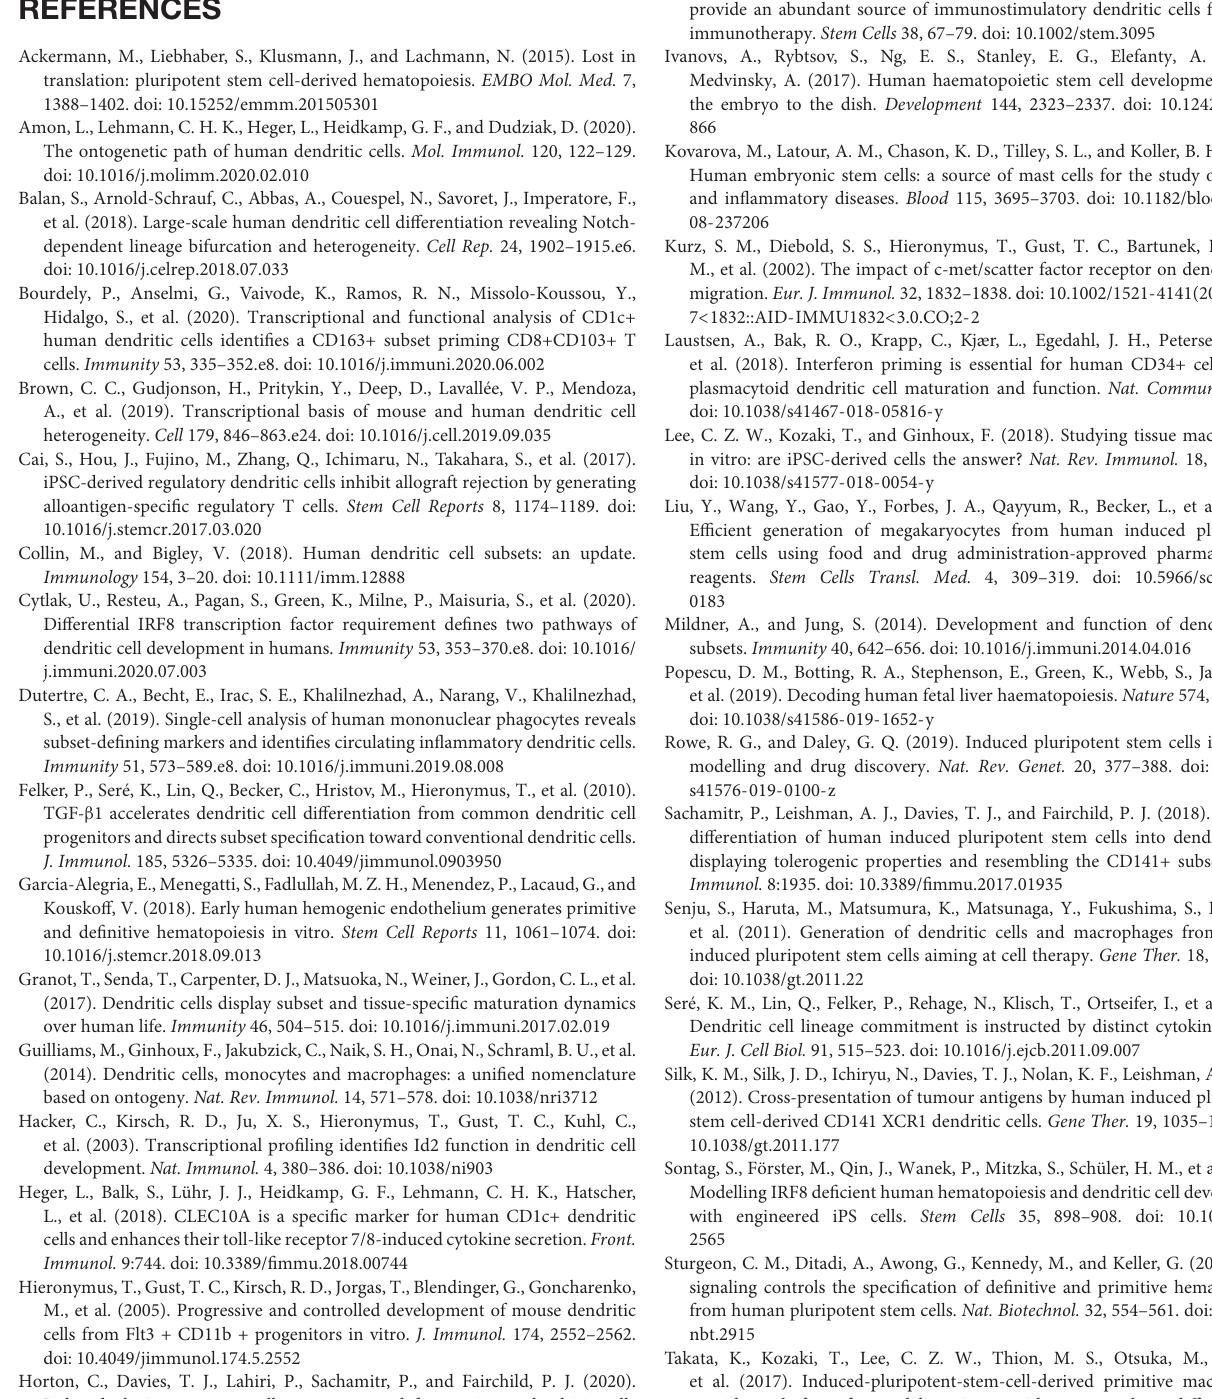
Supplementary Figure 5 | (A) Chemotaxis assay toward CCL19 of JAK2 V617F hom and JAK2 control CD1c + HLA-DR + cells as in Figure 4A . Numbers of migrated cells were determined by flow cytometry and the fold change to the cell number without CCL19 is shown. n = 3, mean ± SD; ns, not significant. (B) TGF β 1 expression in unstimulated and LPS-stimulated HLA-DR + cells of